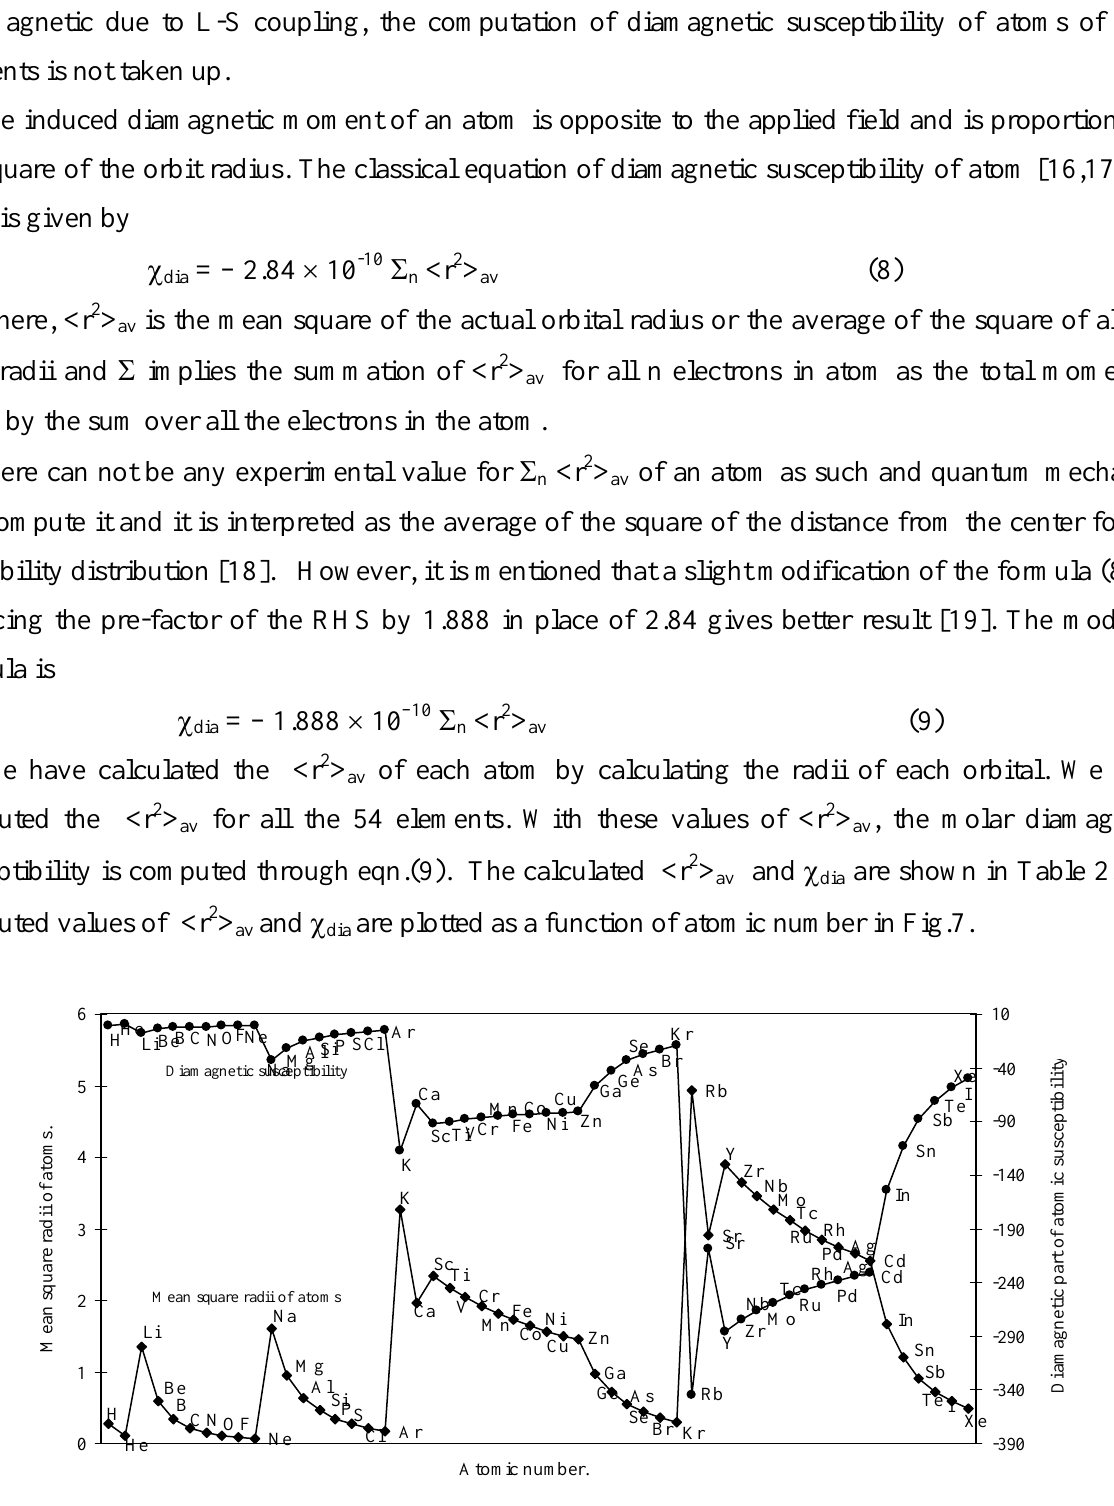
Figure 7. Plot of mean square radii and diamagnetic part of magnetic susceptibility of atoms as a function of atomic